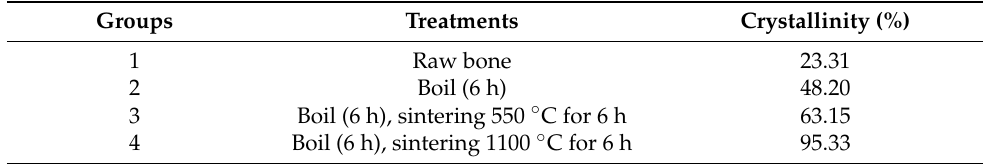
Table 2. Percentage crystallinity of bone samples after different processing